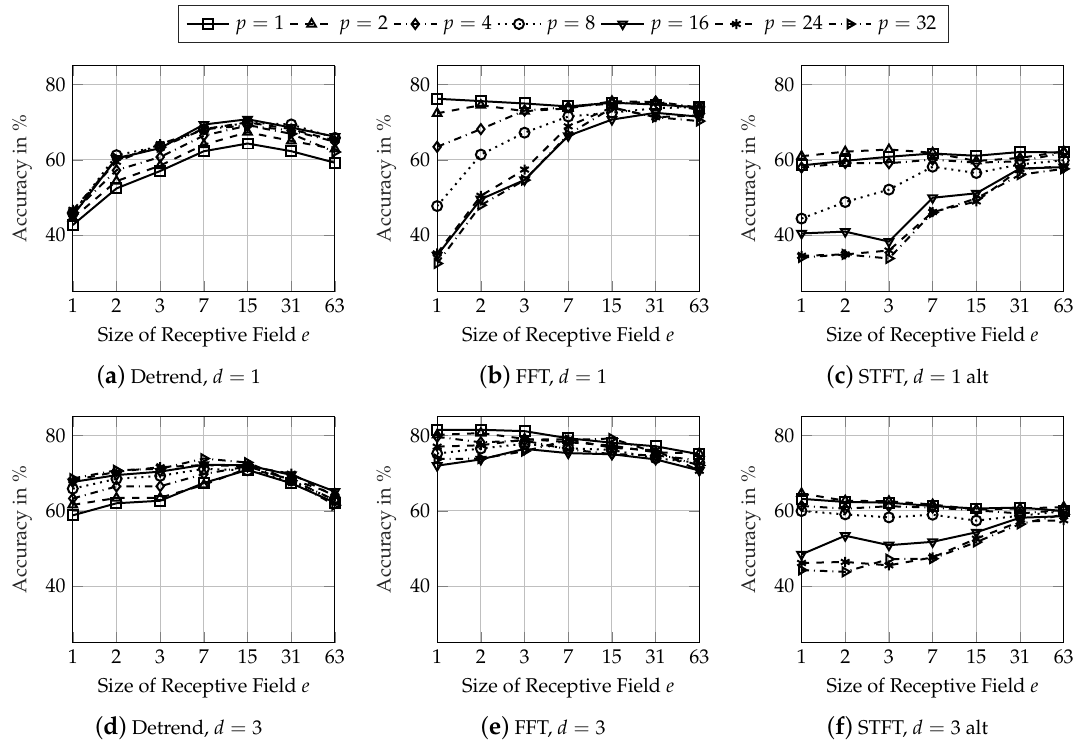
Figure 7. Mean accuracy of the 5-fold cross validation network architectures from Figure 5 applied to the mass variation